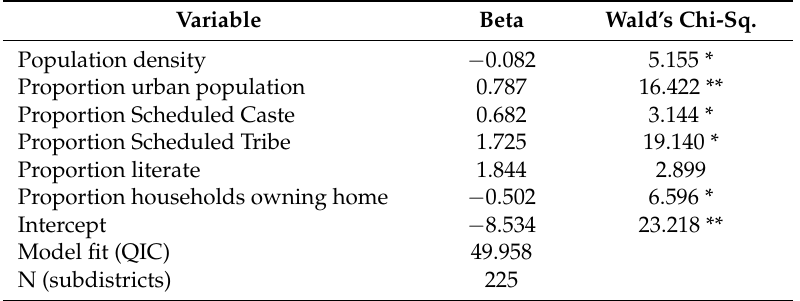
Table 3. Generalized estimating equations (GEEs) for predicting density of all MAH